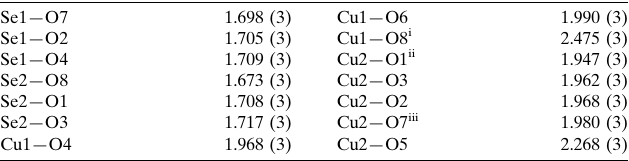
Selected bond lengths (A˚ ).